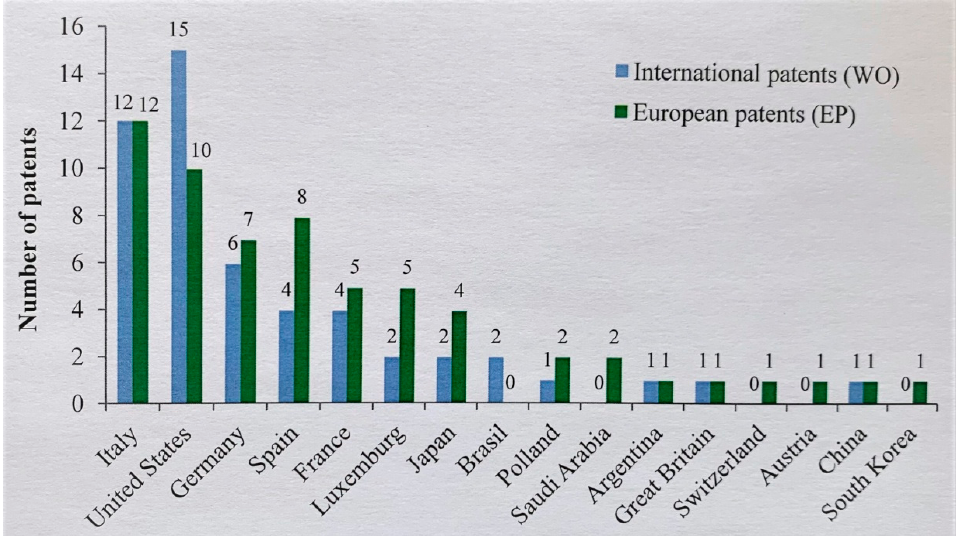
Figure 3. Geographical origin of patents on waste recycling in ceramic mixes, since 2000.